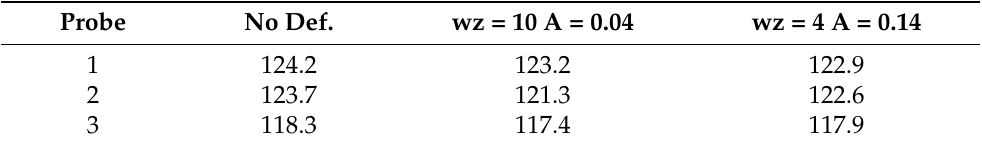
Figure 13. Overall sound pressure level for trailing edge deformations: ( a ) Case 1; ( b ) Case 2; ( c ) Case 3; ( d ) Case 4; ( e ) Case 5. Table 5. Overall Sound Pressure Level results for the probes corresponding to the plate placement of d = 0.65 D j L = 5 D j